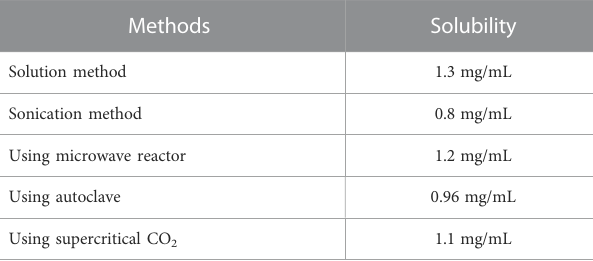
TABLE 1 The water solubilities of icariin in the complex from different methods.